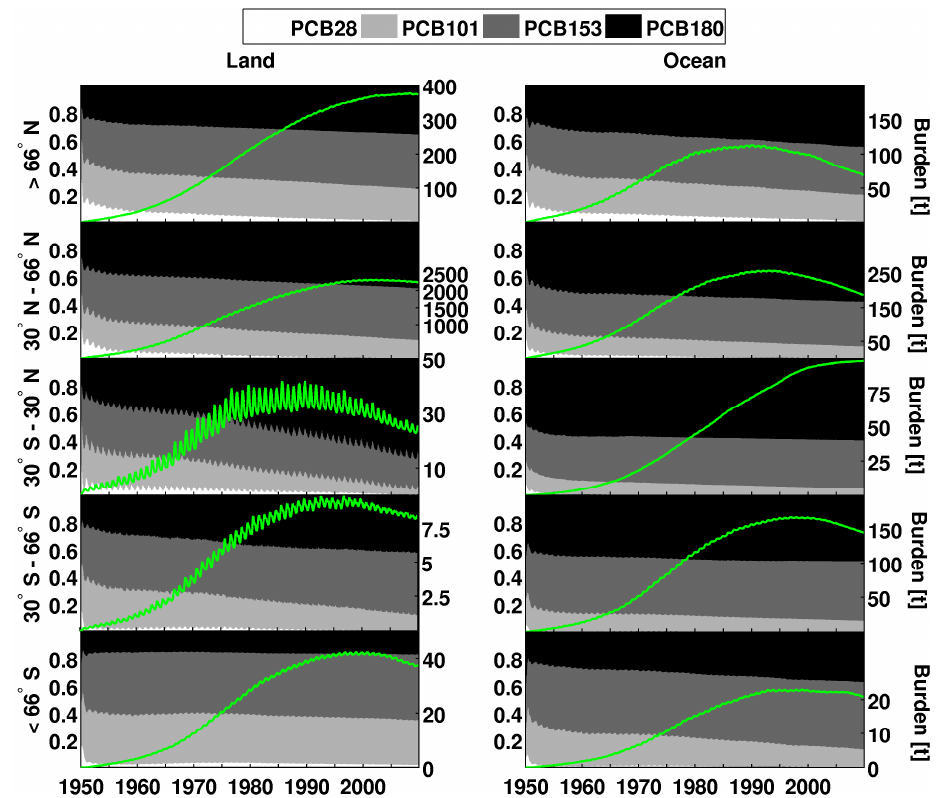
Fig. 7. Fractionation: 1960–2010 trends of the fractions of the individual congener’s total environmental burden in the sum of four PCB Fig. 7: Fractionation: 1960-2010 trends of the fractions of the individual congener's total congeners’ burdens together with the absolute total environmental burden trend (sum of 4 congeners; green line), in land (left) and sea (right) areas of 5 latitudinal bands, i.e. Arctic ( > 66 ◦ N), 30–66 ◦ N, tropics (30 ◦ N–30 ◦ S), 30–66 ◦ S and Antarctic ( > 66 ◦ S). environmental burden in the sum of four PCB congeners' burdens together with the absolute total Table 2. Decadal, i.e. 2001–2010, burden trends (%yr − 1 ) in air and soil for various (a) zonal and (b) meridional bands. Linear regressions environmental burden trend (sum of 4 congeners; blue line), in land (left) and sea (right) areas of 5 of annual latitudinal bands, i.e. Arctic (>66°N), 30-66°N, tropics (30°N-30°S), 30-66°S and Antarctic (>66°S).